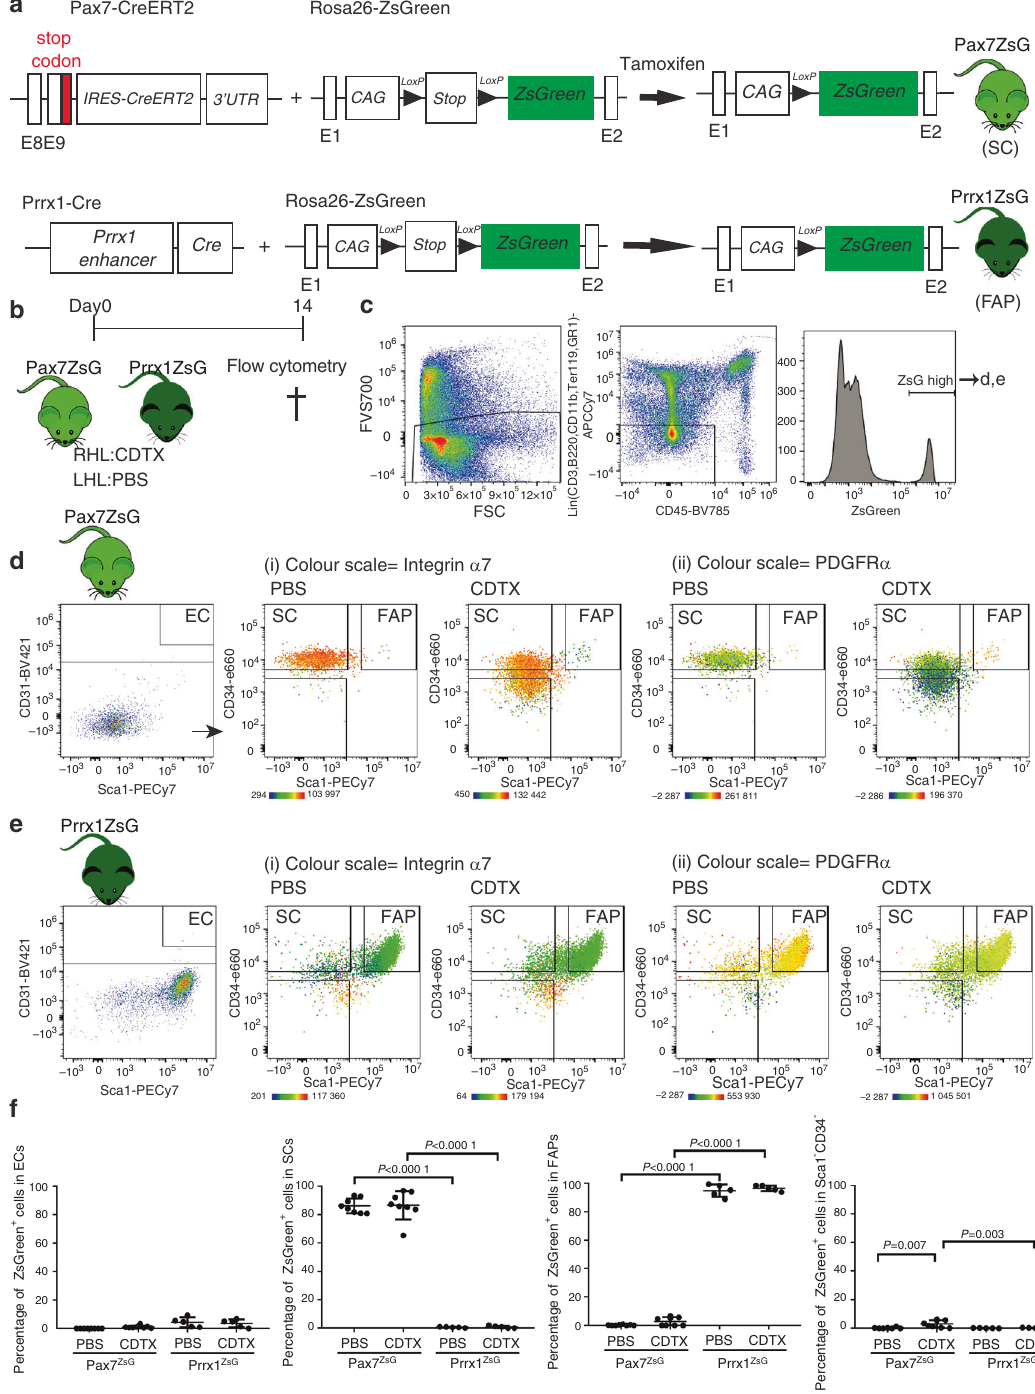
Fig. 1 ZsGreen labels SCs and FAPs in skeletal muscles of the Pax7 ZsG and Prrx1 ZsG mice, respectively. a Schematic representation of tamoxifen-inducible Cre-dependent ZsGreen reporter induction. b Pax7 ZsG ( n = 4/group) and Prrx 1 ZsG ( n = 3/group) mice were injected with CDTX in the hamstring muscle of the right hind limb (RHL) and PBS in the hamstring muscle of the left hind limb (LHL). Muscle cells were isolated 14 days after injection and subsequently stained for surface cell markers. c After gating on forward/side scatters and FVS700 dead cell exclusion, ZsGreen-high cells were gated from Lin − CD45 − nonhematopoietic population in both ( d ) Pax7 ZsG and ( e ) Prrx1 ZsG mice and further subgrouped into CD31 + Sca1 + (EC), CD31 − Sca1 − CD34 + (SCs), CD31 − Sca1 + CD34 + (FAPs), and Sca1 − CD34 − populations. The color indicates the expression level of ( i ) integrin α 7 and ( ii ) PDGFR α . Yellow-orange: high expression. Green: low expression. f Frequencies of ZsGreen + cells in Sca1 + CD31 + ECs, CD31 − Sca1 − CD34 + ITGA7 + PDGFR α − SCs and CD31 − Sca1 + CD34 + ITGA7 − PDGFR α + FAP populations from muscles of the Pax7 ZsG and Prrx1 ZsG mice following the gating strategy in Fig. S1. Each dot represents a separate mouse, and bars are the mean ± SD. The results of 8 mice per group were from 3 independent experiments performed over a period of 2 years with different fl ow cytometers. Signi fi cance was analyzed by one-way ANOVA with Tukey ’ s multiple comparison